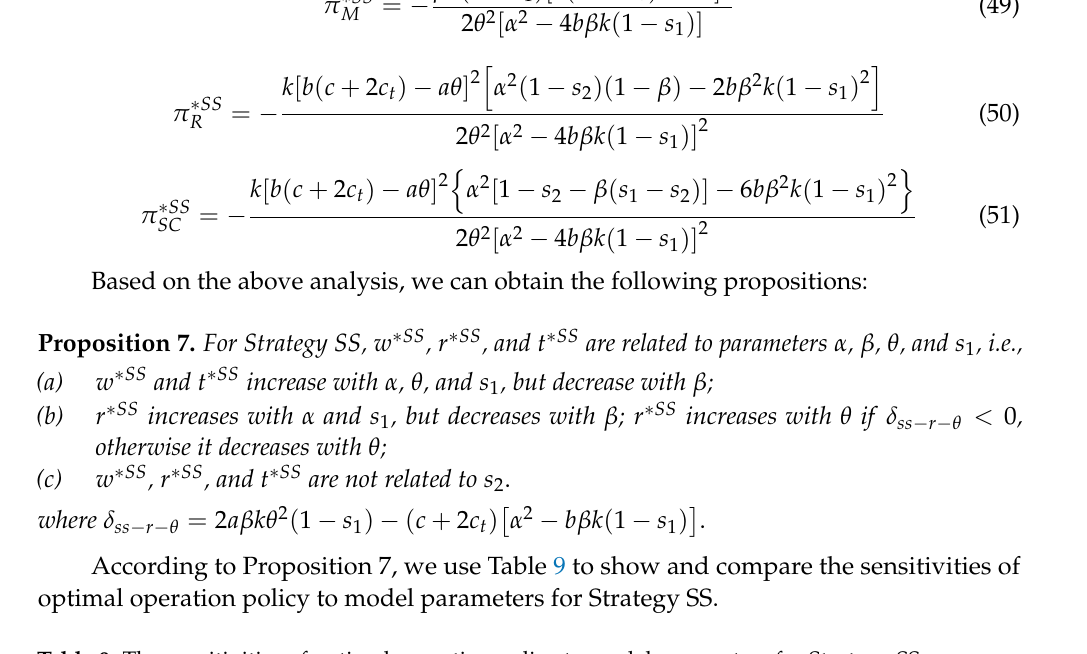
Table 9. The sensitivities of optimal operation policy to model parameters for Strategy SS. α β θ s 1 s 2 w ∗ SS ↑ ↓ ↑ ↑ – r ∗ SS ↑ ↓ ↓↑ ↑ – t ∗ SS ↑ ↓